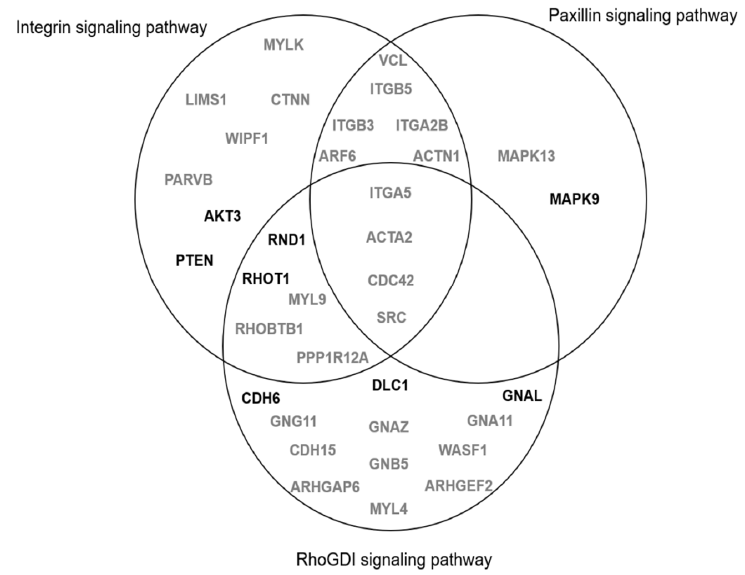
Figure 4. Exclusive and common genes downregulated (bold) and upregulated (gray) among integrin, paxillin, and Rho guanosine diphosphate dissociation inhibitor (RhoGDI) signaling pathways predicted to be modulated in elderly individuals with T2D. MYLK, myosin light chain kinase; ACTN1, actinin alpha 1; ACTA2, actin alpha 2; AKT3, AKT serine/threonine kinase 3; ARF6, ADP ribosylation factor 6; ARHGAP6, Rho GTPase activating protein 6; ARHGEF2, Rho/Rac guanine nucleotide exchange factor 2; CDC42, cell division cycle 42; CDH6, cadherin 6; CDH15, cadherin 15; CTNN, beta catenin; DLC1, DLC1 Rho GTPase activating protein; GNA11, G protein subunit alpha 11; GNAZ, G protein subunit alpha z; GNAL, G protein subunit alpha L; GNB5, G protein subunit beta 5; GNG11, G protein subunit gamma 11; ITGB3, integrin subunit beta 3; ITGB5, integrin subunit alpha 5; ITGA2B, integrin subunit alpha 2b; ITGB5, integrin subunit beta 5; LIMS1, LIM zinc finger domain containing 1; MAPK13, mitogen-activated protein kinase 9; MAPK13, mitogen-activated protein kinase 13; MYL4, myosin light chain 4; MYL9, myosin light chain 9; PTEN, phosphatase and tensin homolog; WIPF1, WAS/WASL interacting protein family member 1; PARVB, parvin beta; PPP1R12A, protein phosphatase 1 regulatory subunit 12A; RND1, Rho family GTPase 1; RHOT1, ras homolog family member T1; RHOBTB1, Rho related BTB domain containing 1; SRC, SRC proto-oncogene, non-receptor tyrosine kinase; VCL, vinculin; WASF1, WASP family member 1.